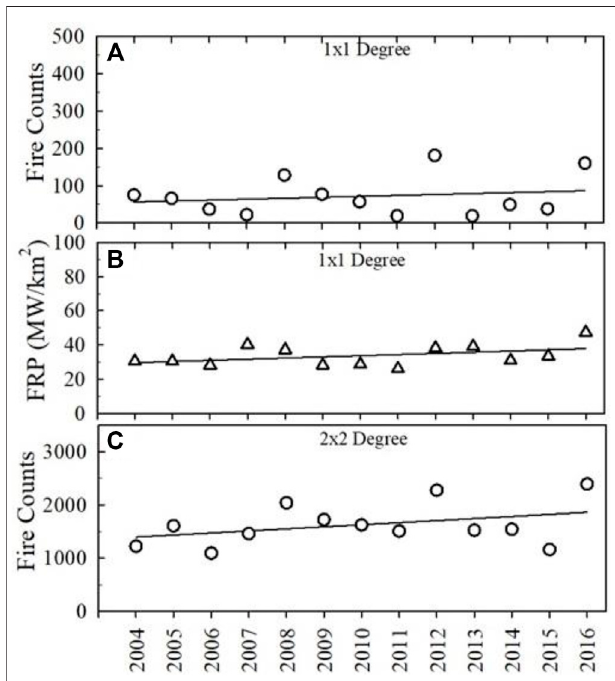
FIGURE 9 | Variation in (A) MODIS fi re count over 1×1 degree grid box region centred at the observational site Nainital (B) Variation in the Fire Radiative Power (FRP). (C) Trend in fi re count over 2×2 degree region is also